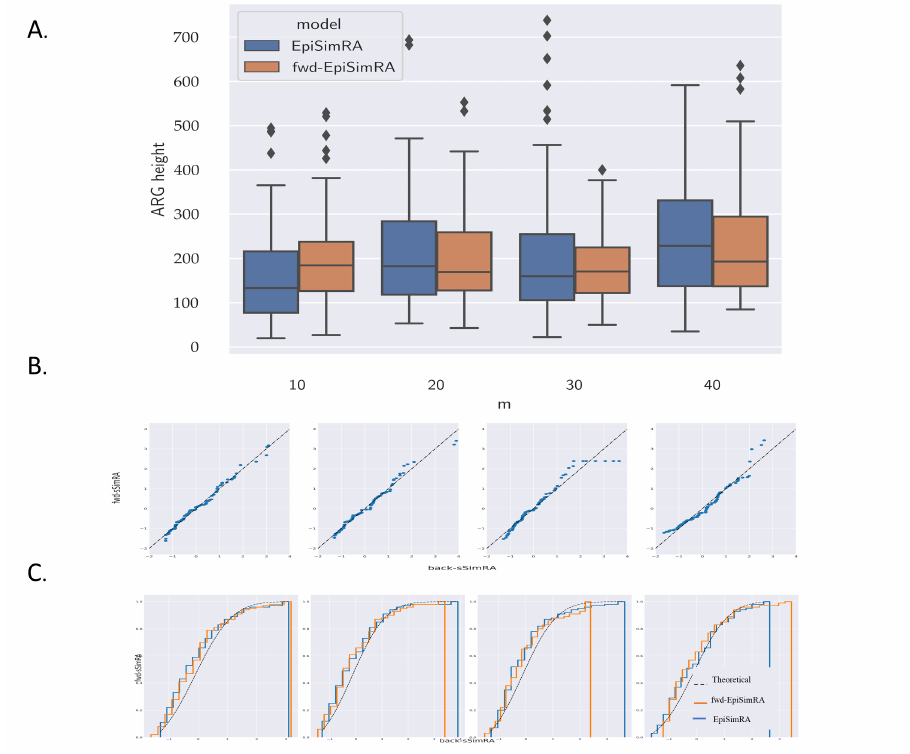
Figure A3. Comparing the height of the ARG (H) between fwd-EpiSimRA and EpiSimRA with and without epistatis in two loci with recombination for N = 100, g = 250 kbp, r = 1.0 × 10 − 8 , m = { 10.20,30,40 } , s = { 0.3,0.3 } with epistastic parameters for s 0 s 1 = 0.15. ( A ) The box-and- whisker diagram summarizes the result for each. On each box, the central mark is the mean, the edges of the box are the 25th and 75th percentiles, the whiskers extend to the most extreme data points not considered outliers, and outliers are plotted individually. ( B ) QQ plot and ( C ) CDF plot of the backward and forward models show similar